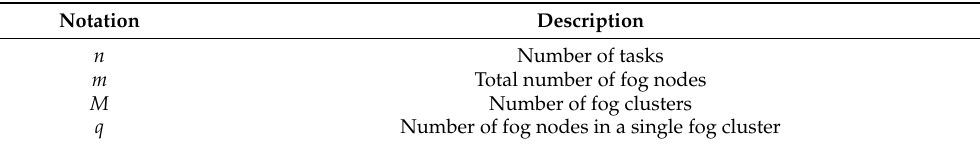
Table 1. Mathematical